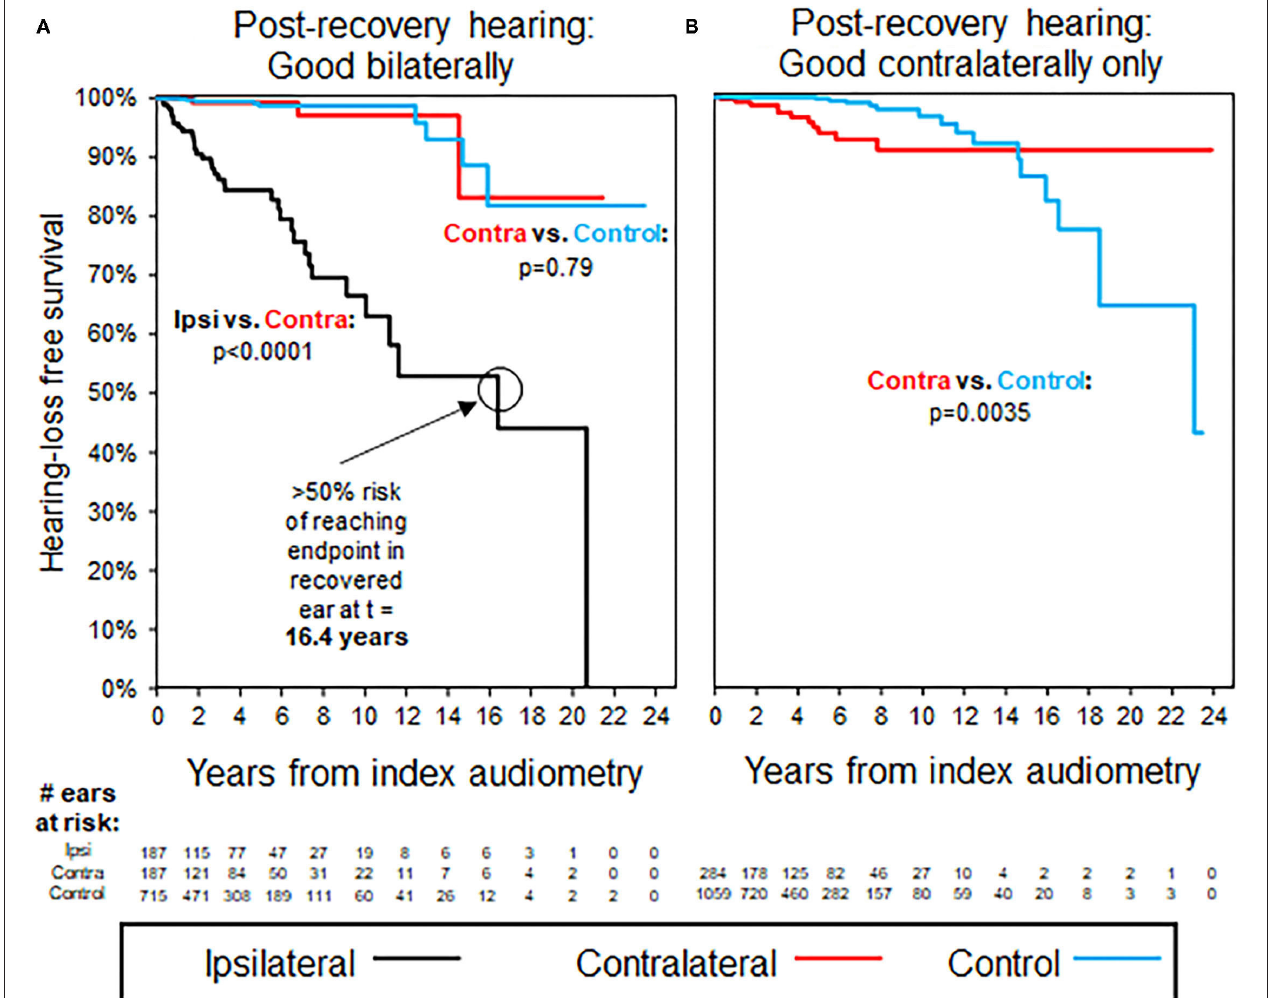
FIGURE 2 | Kaplan–Meier curves for hearing loss progression in the patients with unilateral ISSNHL and good baseline hearing in the ISSNHL-contralateral ear; as shown in Table 2 for demographics. (A) The patients with good hearing bilaterally, endpoint non-serviceable hearing. (B) The patients with good hearing in ISSNHL-contralateral ear only, endpoint non-serviceable hearing. All the control ears with good